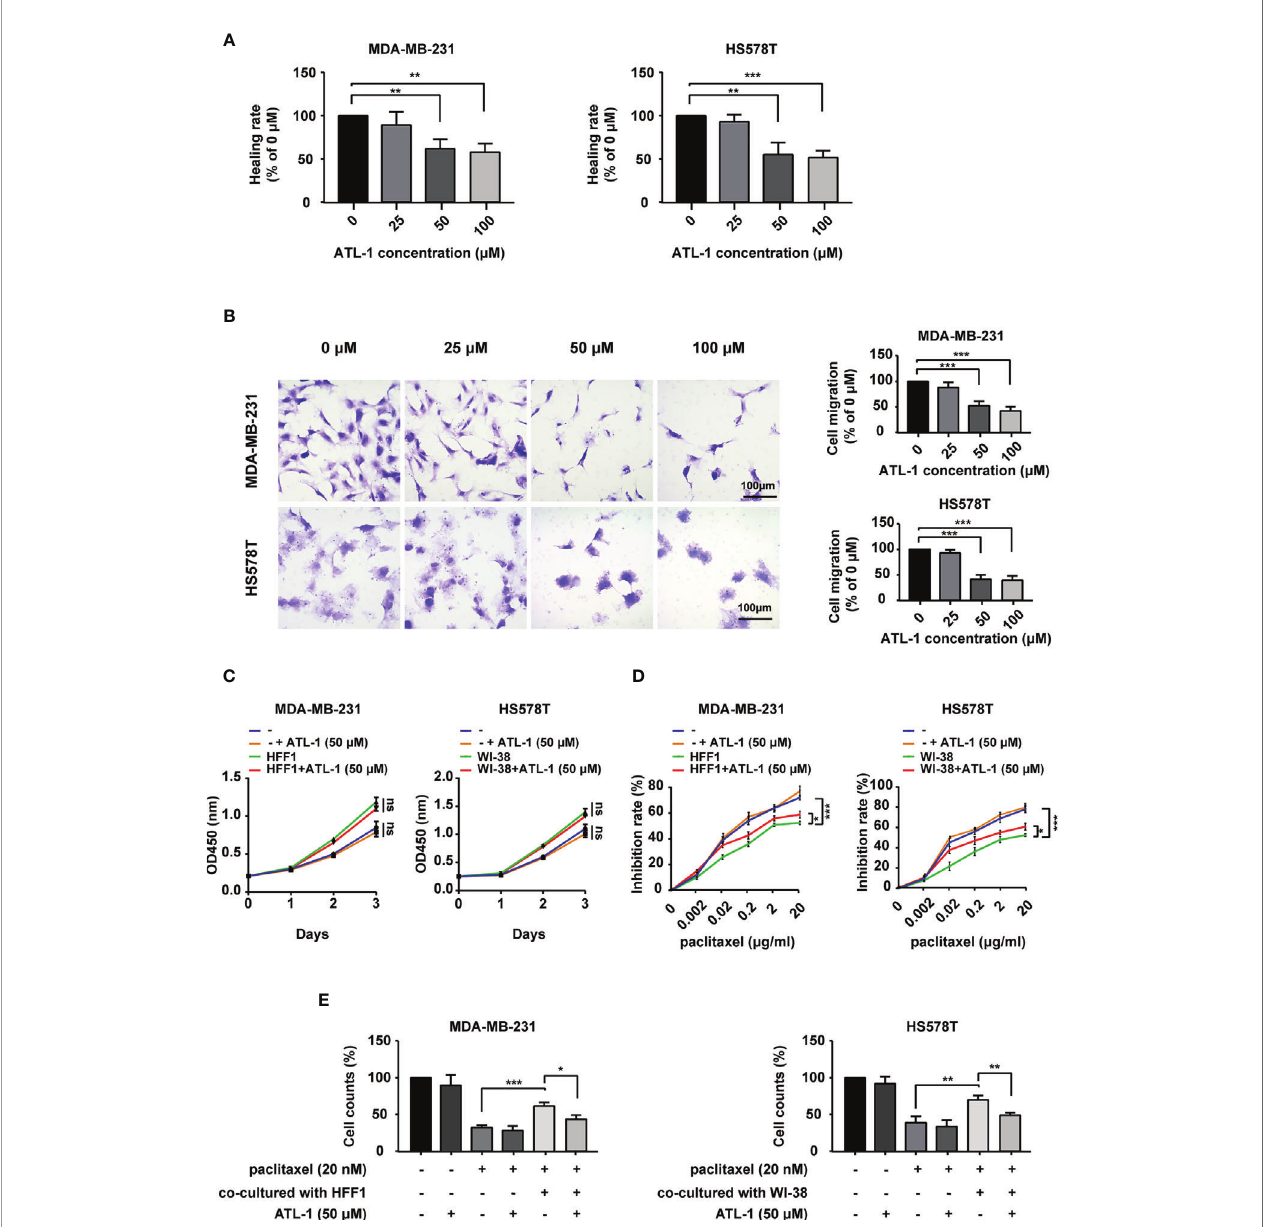
FIGURE 1 | ATL-1 inhibited tumor cell migration and increased the sensitivity of tumor cells to paclitaxel. Wound healing (A) and Transwell migration (B) assays showed that 50 m M and 100 m M ATL-1 reduced the migratory capacities of MDA-MB-231 and HS578T cells. (C) CCK8 assays showed that 50 m M ATL-1 alone had no growth-inhibiting effect on MDA-MB-231 and HS578T cells cultured alone ( – ) or co-cultured with fi broblasts (HFF1 or WI-38 cells). (D) CCK8 assays showed the growth-inhibiting effects of paclitaxel on MDA-MB-231 and HS578T cells cultured alone ( – ) or co-cultured with fi broblasts (HFF1 or WI-38 cells) with or without 50 m M ATL-1 treatment for 48 hrs. (E) Trypan blue exclusion assay showed the live cell counts after paclitaxel treatment on MDA-MB-231 and HS578T cells cultured alone or co-cultured with fi broblasts with or without 50 m M ATL-1 treatment for 48 hrs. (A – E) Three technical replicates were performed for each of the three biological replicates. Mean ± SD, *p < 0.05, **p < 0.01, ***p < 0.001 by Student ’ s t